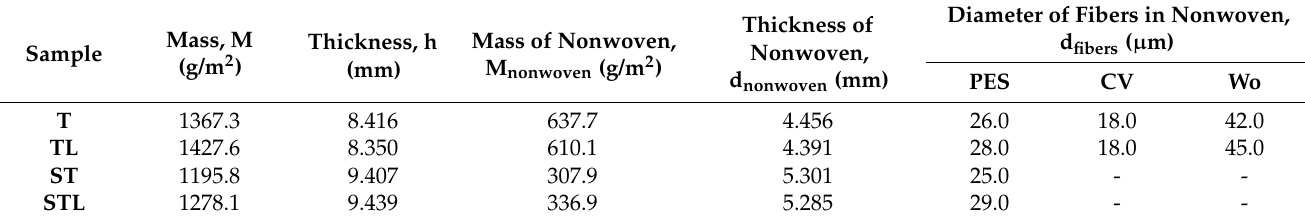
Table 2. Structural properties of the samples.